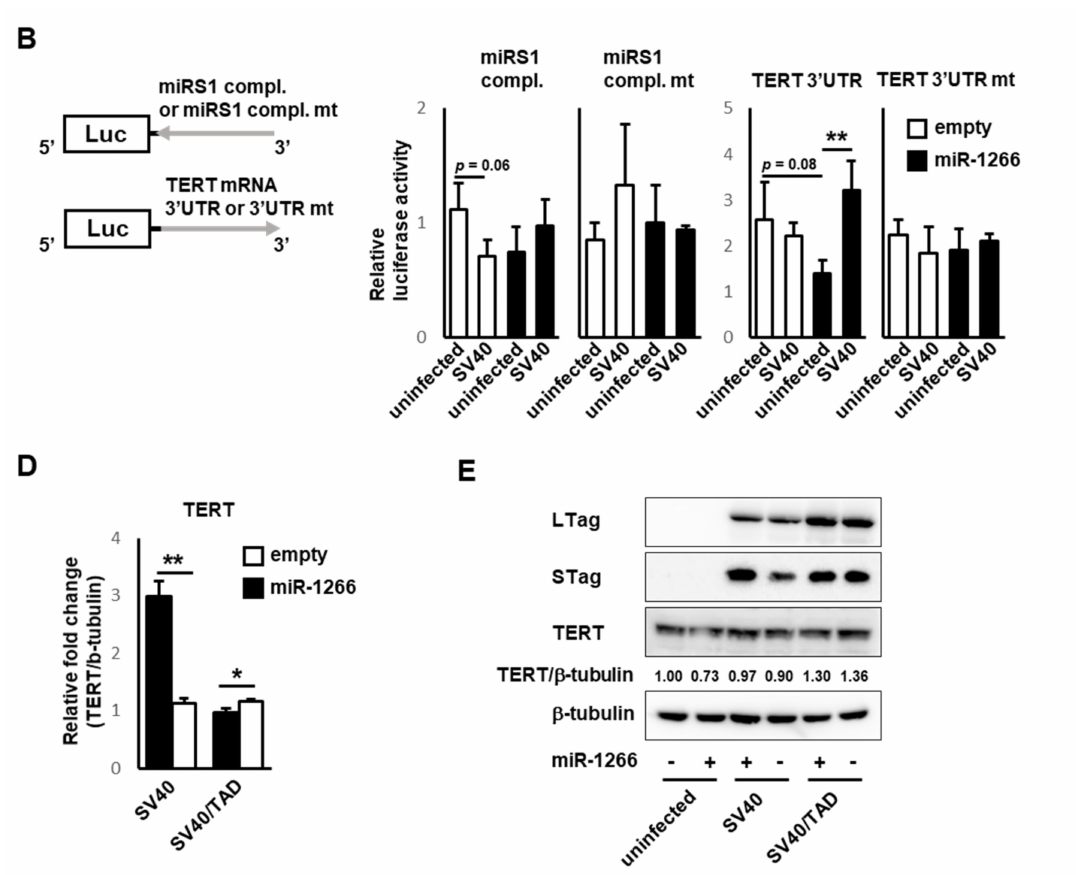
Figure 5. MiR-S1 induced by SV40 infection and miR-1266 mutually interfere with their respective targets, namely, TERT and T antigens. ( A , C ) Total RNAs were extracted from control and miR-1266 − expressing A549 cells infected with SV40 or SV40/TAD. At 3 dpi, total RNAs were subjected to RT-qPCR for miR-1266-5p and miR-S1-3p. Levels of miR-1266-5p, miR-S1-3p, and LSTag were deter- mined by RT-qPCR. Levels of LTag and STag mRNA were also sorely detected by semiquantitative RT-PCR. All experiments were repeated two times. Columns, mean values ( n = 3); bars, SD; ** p < 0.01. ( B ) Uninfected or SV40-infected control and miR-1266 − expressing A549 cells were cotransfected with internal pGL control vector and pRL-Luc, pRL-Luc-miR-S1 compl., pRL-Luc-miR-S1 compl. mt, pRL-Luc-hTERT-3 (cid:48) UTR, or pRL-Luc-hTERT-3 (cid:48) UTR mt at a molar ratio of 1:5. The relative luciferase activities were calculated by dividing the value of pRL-Luc by the value of pGL. All experiments were repeated two times. Columns, mean values ( n = 3); bars, SD; ** p < 0.01. ( D ) Total RNAs from control and miR-1266 − expressing A549 were infected with SV40 or SV40/TAD. At 3 dpi, total RNAs were subjected to RT-qPCR for TERT mRNA. Columns, mean values ( n = 3); bars, SD; * p < 0.05; ** p < 0.01. ( E ) Levels of LTag, STag, and TERT proteins in uninfected or SV40-infected control and miR-1266 − expressing A549 cells were determined using immunoblot analysis. Expression ratios of TERT protein (TERT/beta-tubulin) were calculated using ImageJ software. All experiments were repeated two